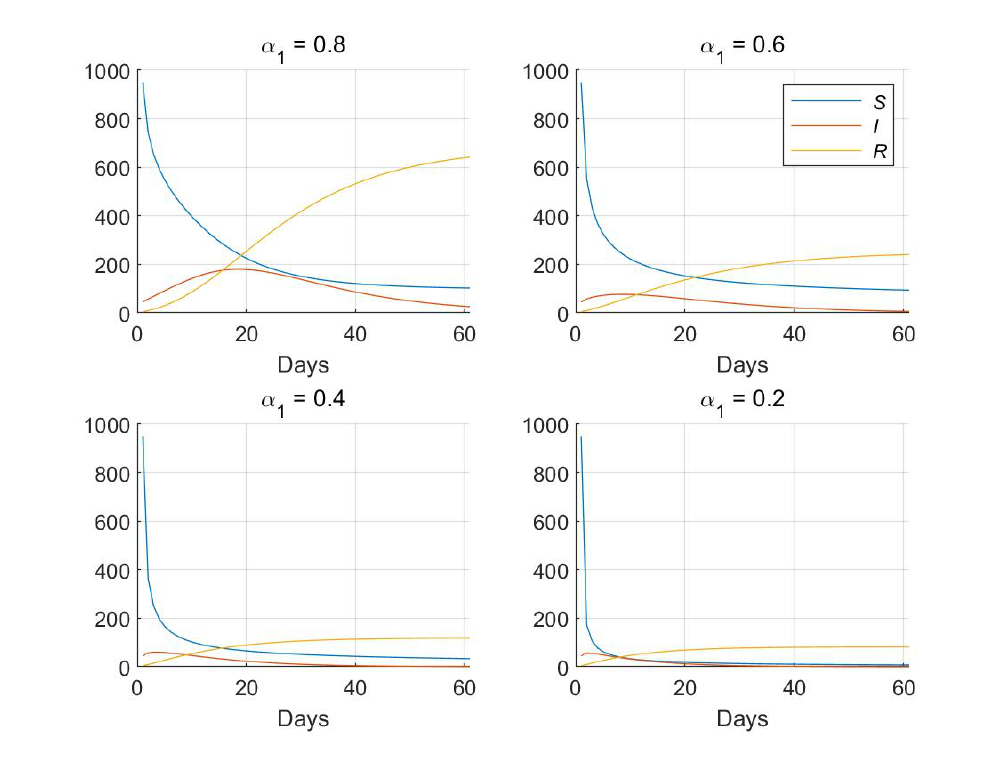
Figure 1. Simulation results for various α 1 and α 2 = α 3 = 1.